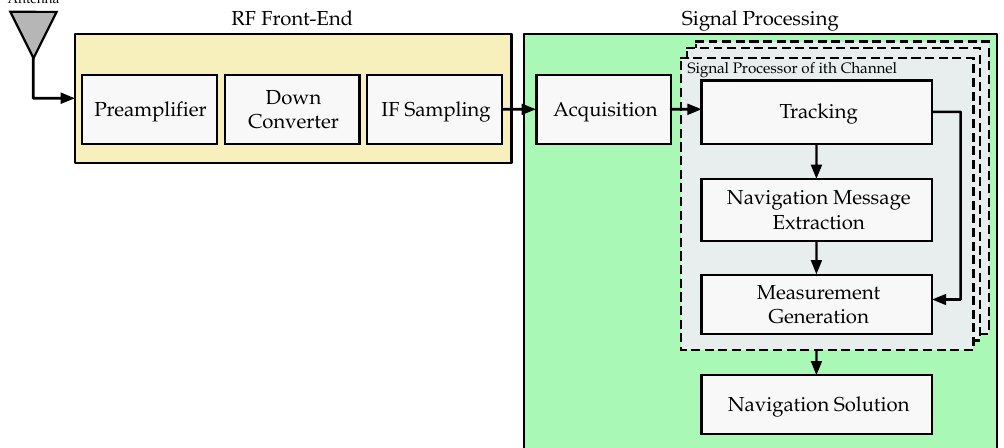
Figure 1. High-level architecture of a global positioning system (GPS) receiver .